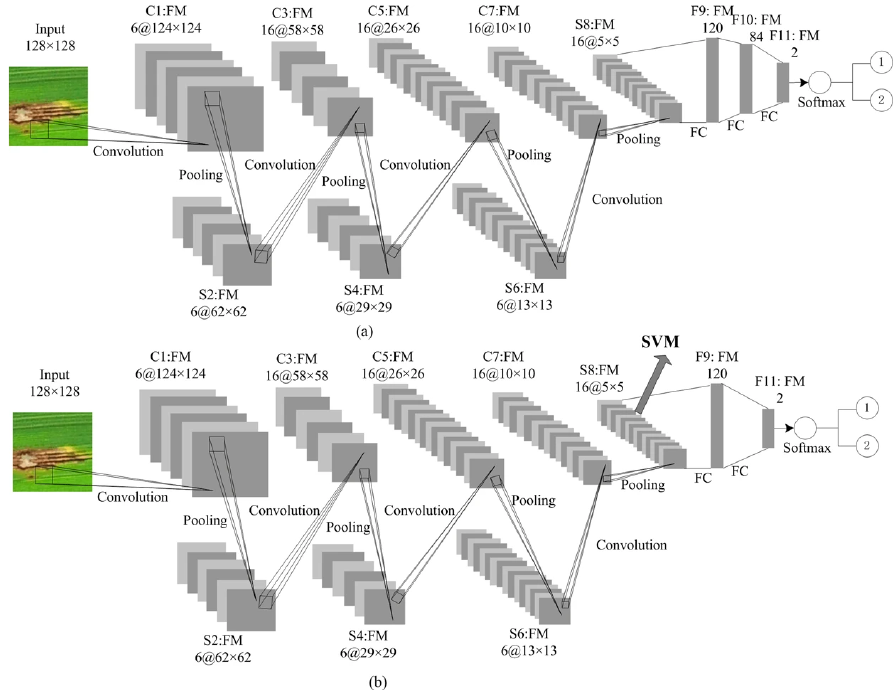
Figure 3. Deep Convolutional Neural Network architecture for the detection of rice blast